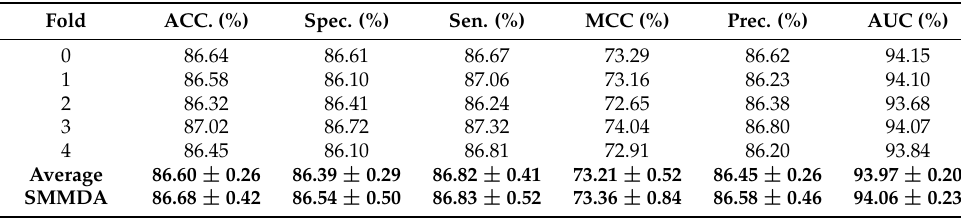
Table 2. Evaluation of our method with different feature combinations.